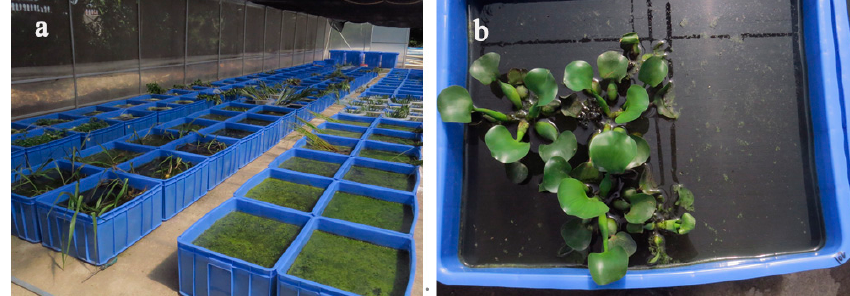
Figure 1. Experimental scene on the first day: ( a ) all plants and ( b ) Eichhornia crassipes.